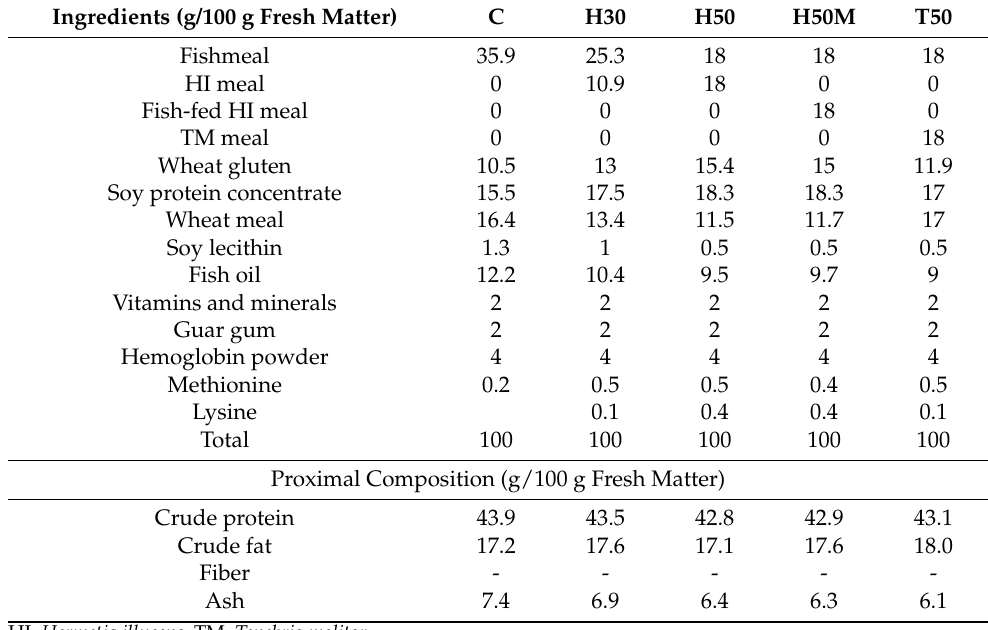
Table 3. Ingredients and proximal composition of elaborated diets used in experiment. Ingredients (g/100 g Fresh